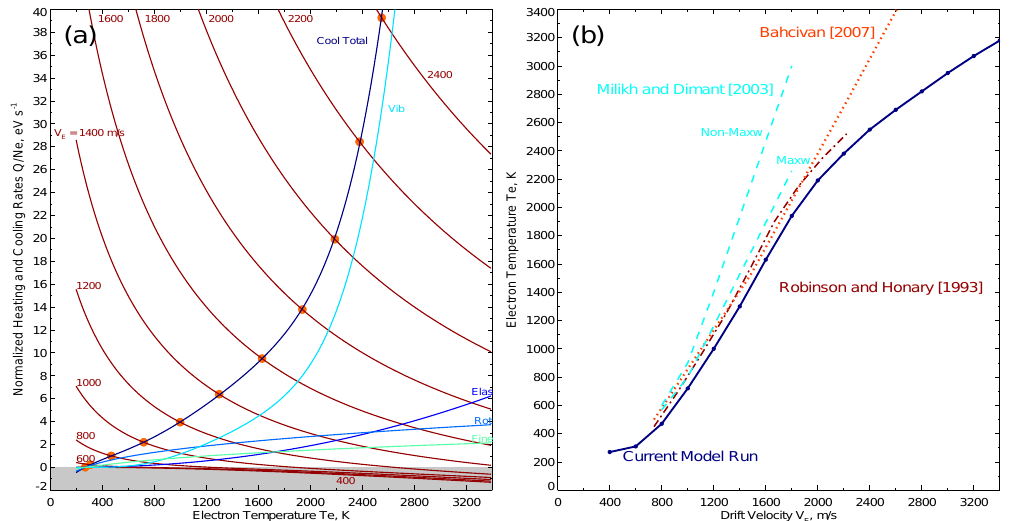
Fig. 2. (a) Normalised heating and cooling rates versus the electron temperature. Red lines are the heating rate function Q divided by the electron density N e for different values of the convection drift speed V E . The blue and green lines are (from top to bottom): total cooling rate, cooling due to vibrational excitation of N 2 and O 2 , cooling due to elastic electron-neutral interactions, cooling due to rotational excitation of N 2 and O 2 , and cooling due to fine structure excitation of O. Red circles indicate balance temperatures between heating and cooling. (b) Various model dependencies of electron temperature versus convection drift velocity. The solid line shows the results of the current fluid model from panel (a) . Other selected model results are also shown as indicated in Fig. 2b and explained in the text.